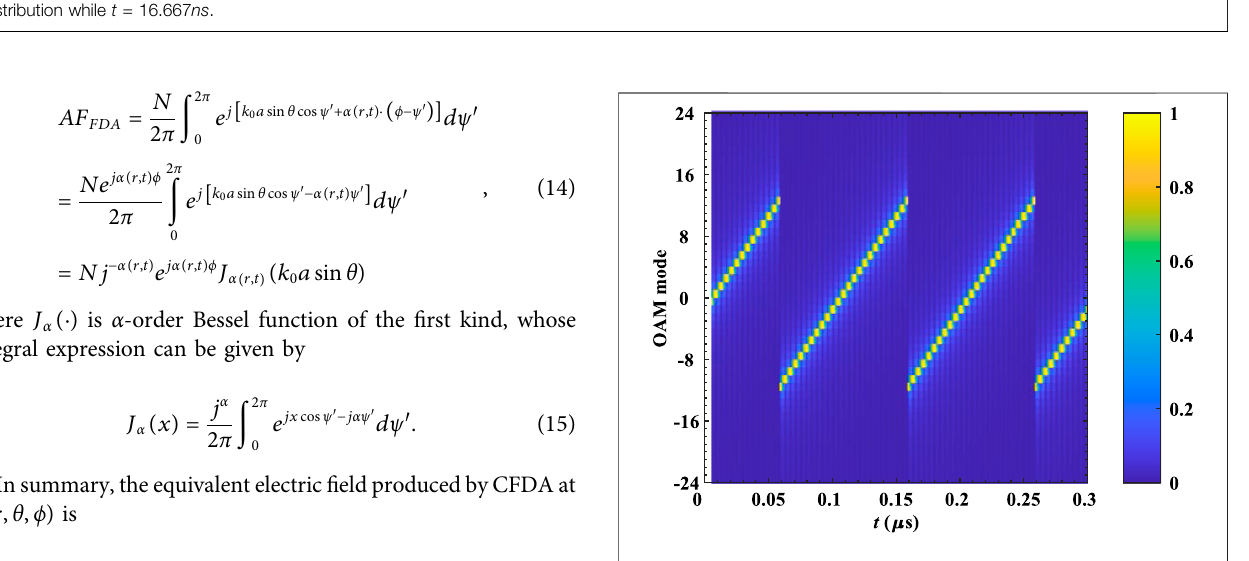
FIGURE 4 | CFDA-based OAM spectrum with time while r = 2.5 m .